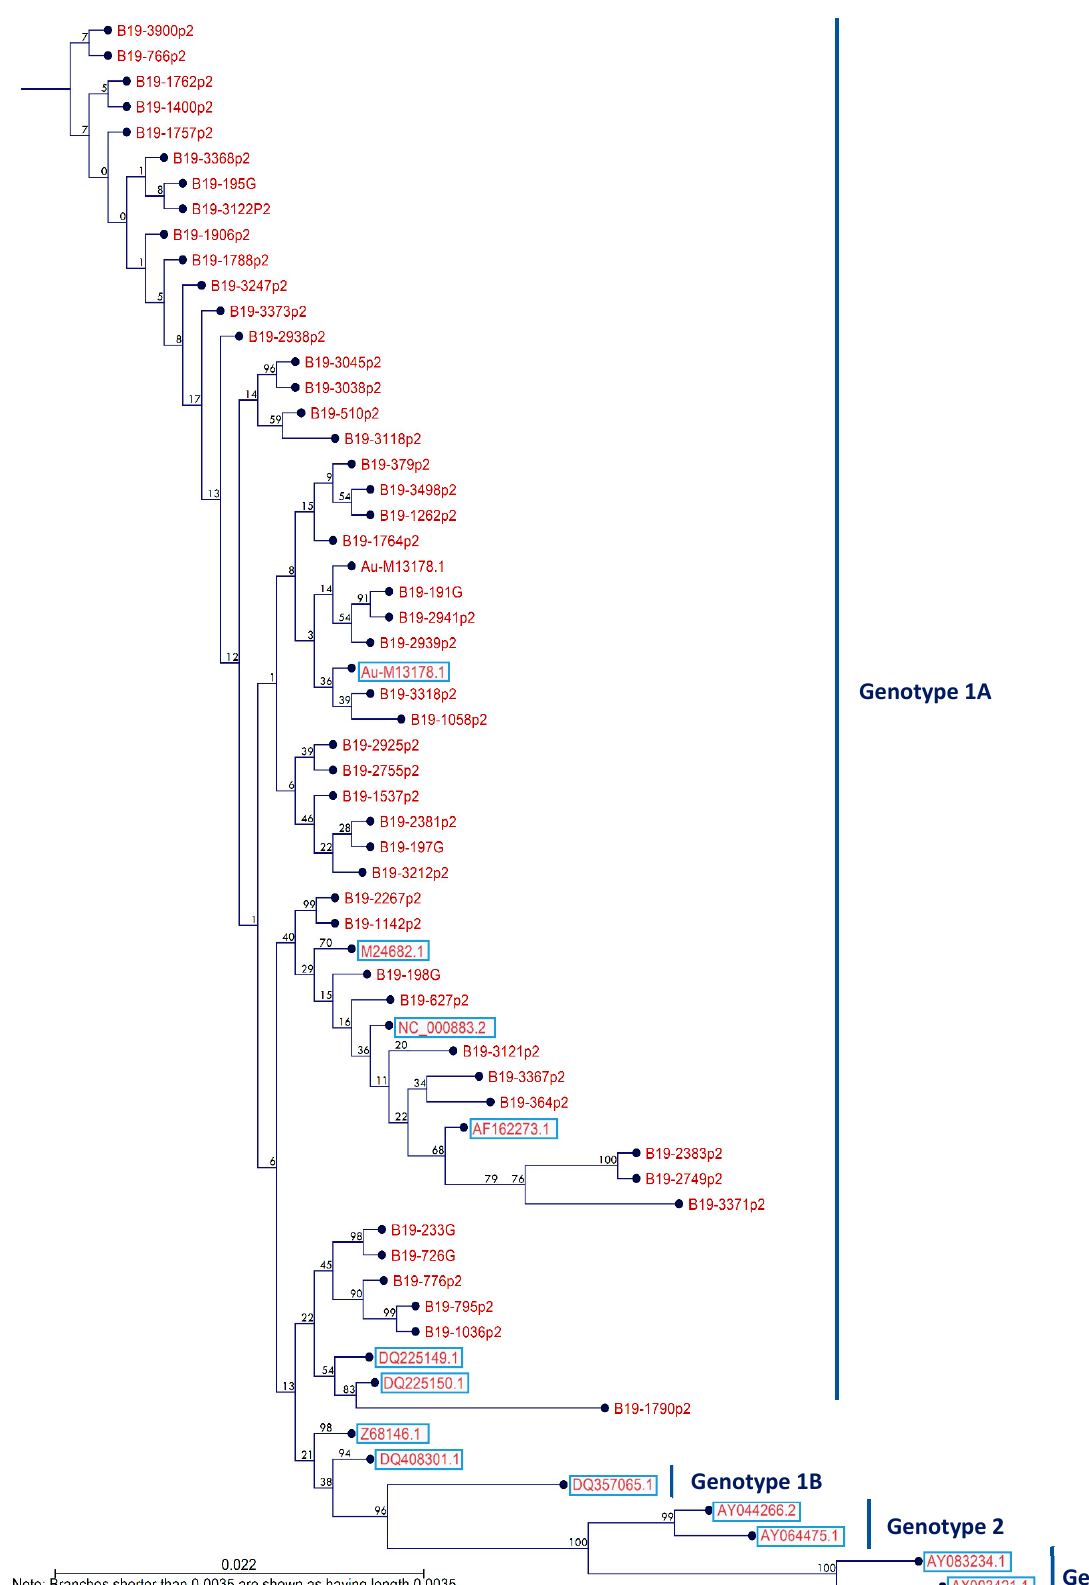
Figure 2. Phylogenetic tree of B19V based on the NS1-VP1u region using the neighbor-joining method and the Kimura 2 parameter model. The reference sequences are shown inside the boxes and are labeled with their GenBank accession numbers. Bootstraps values of 1000 replicates are indicated above the nodes. Branch lengths are drawn to scale.